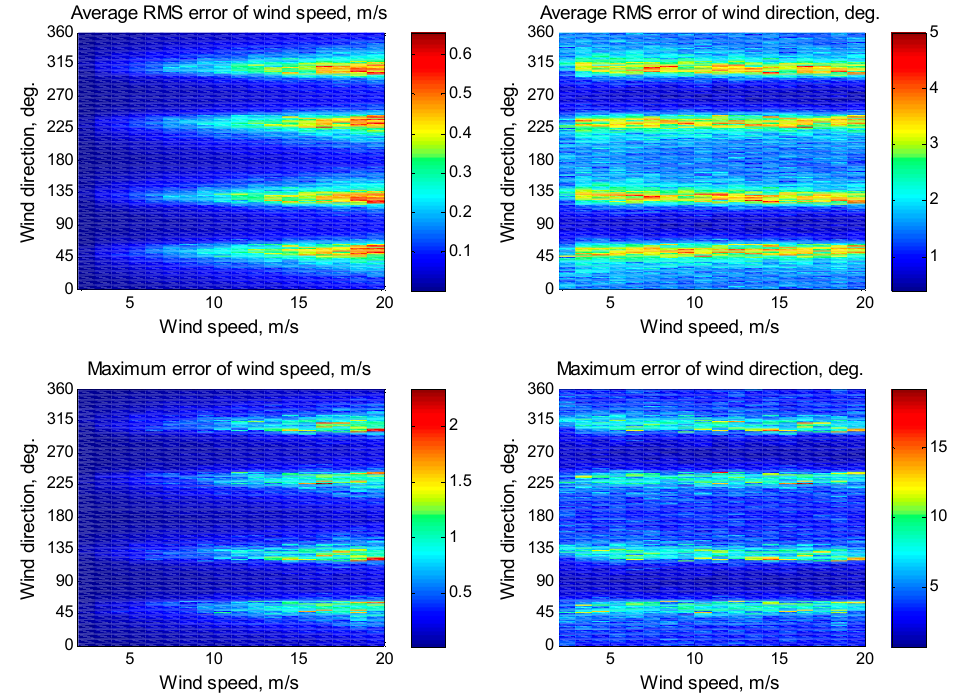
Figure 7. Simulation results for the mounting angle of a beam axis in the horizontal plane of 15° without instrumental noise at wind speeds of 2–20 m/s for the incidence angle of 30° with 5000 averaged NRCS samples for each azimuthal angle.